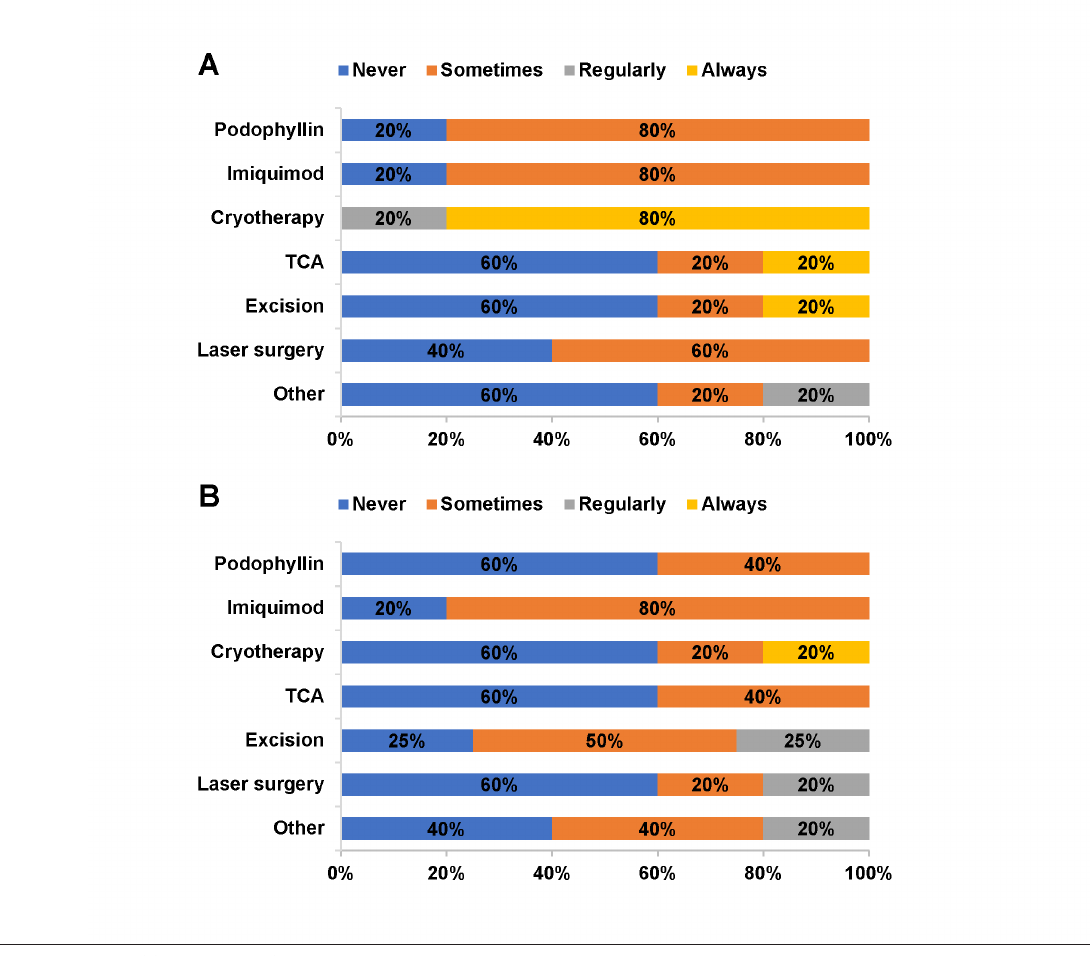
Abbreviation: TCA, trichloroacetic acid. a n=4 for excision as second-line